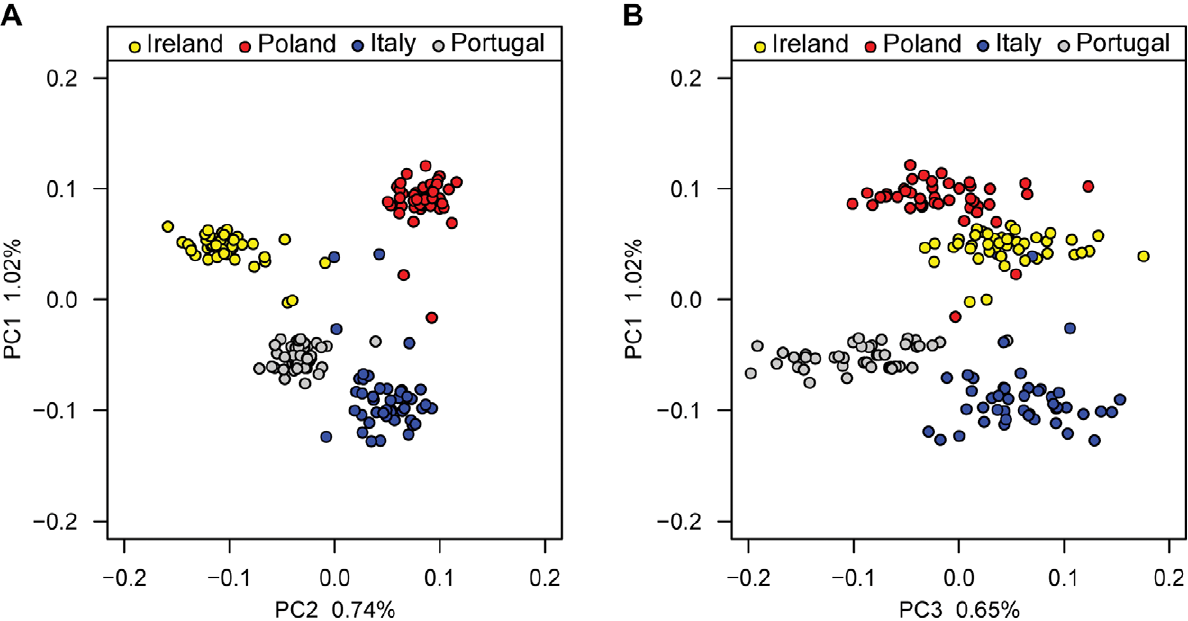
Figure 3. Population structure of the GWAS samples. ( A ) Plots of GWAS individuals on genetic PC1 and PC2 show that individuals largely cluster by country of sampling. PC1 divides the samples according to a North/South geographical axis, while PC2 divides the samples along an East/ West geographical axis. Individuals from Ireland, Poland, Italy, and Portugal are colored in yellow, red, blue, and gray, respectively. ( B ) The plot of individuals on PC1 and PC3 shows that individuals from Portugal tend to have lower values on PC3 than individuals from Italy and Ireland, while individuals from Poland have intermediate values on PC3.